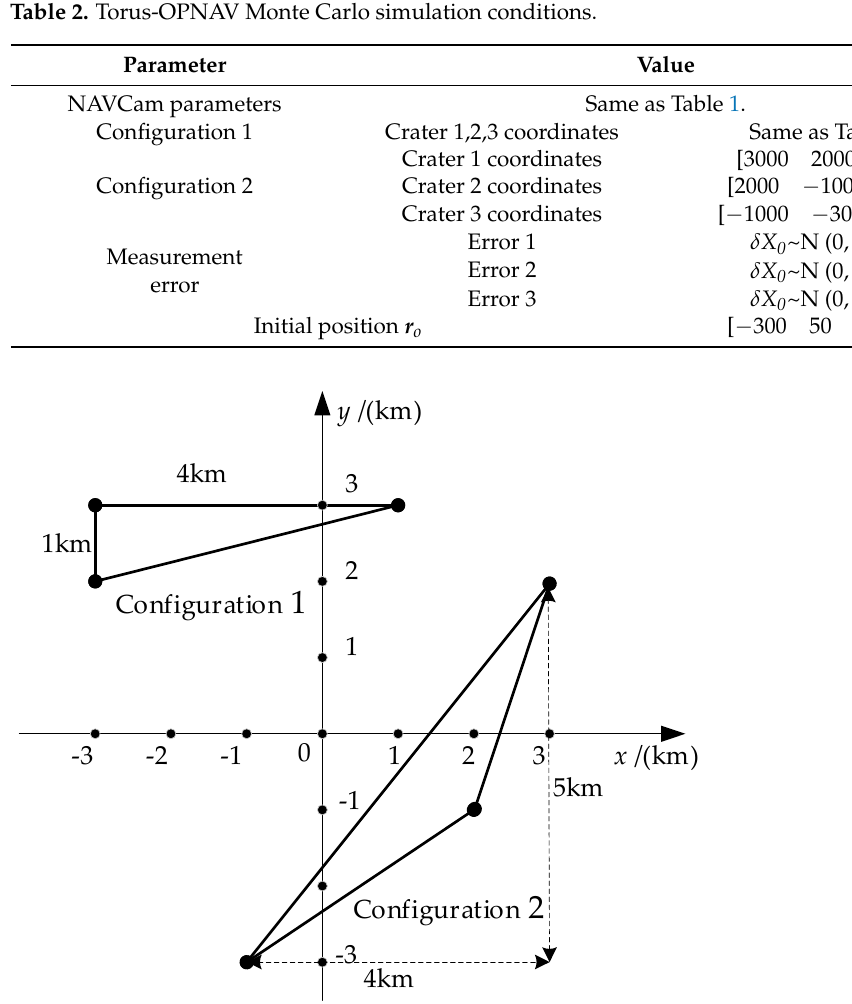
Table 2. Torus-OPNAV Monte Carlo simulation conditions.